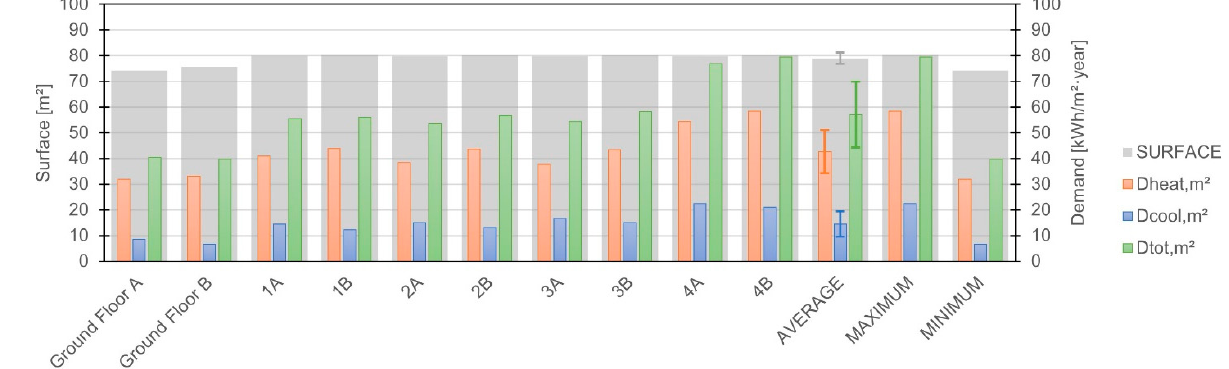
Figure 9. Dwelling annual thermal demand for the as-built hypothesis, including the surface of each